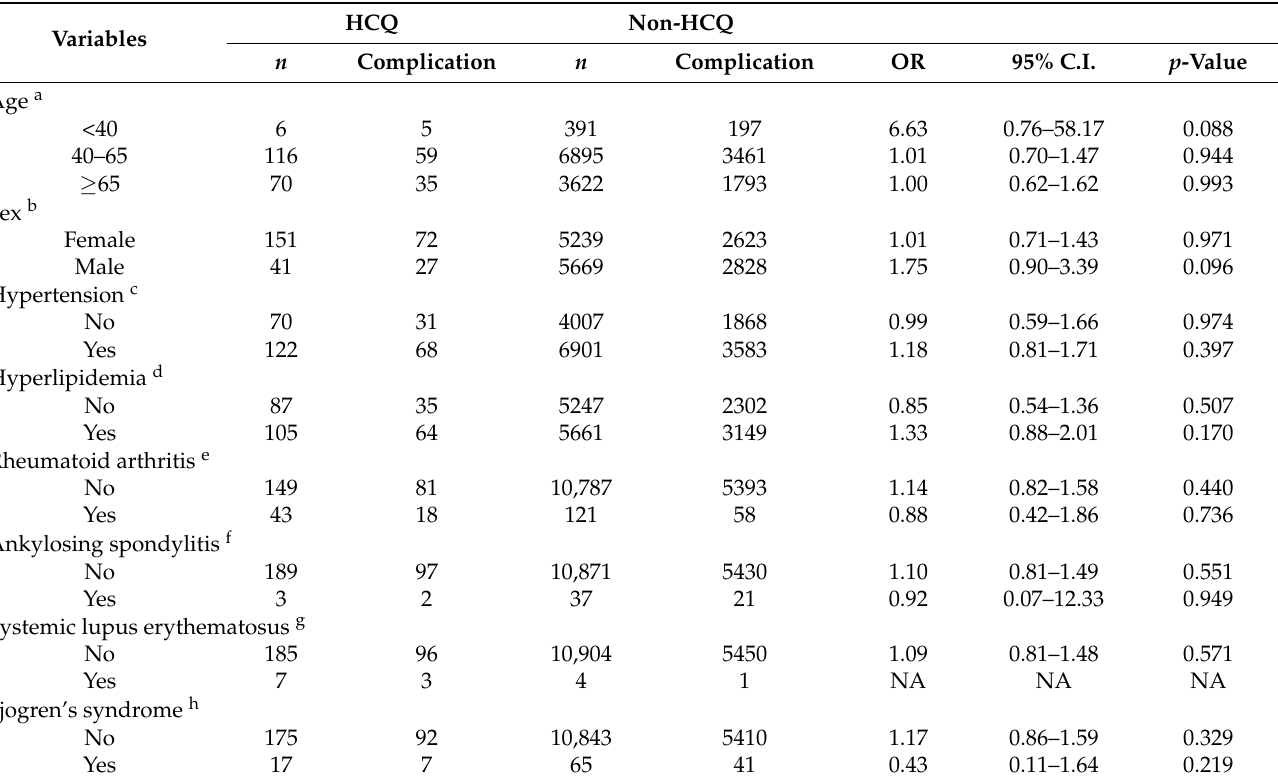
Table 3. Subgroup analysis of risk of ophthalmic complications.